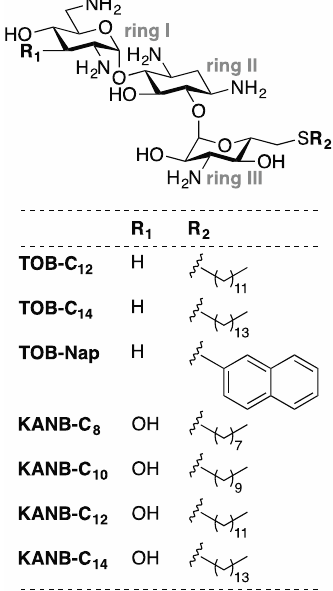
Figure 1. Compounds analyzed in this study. Related aminoglycosides TOB and KANB were modified with various 6” ‐ thioether substituents to generate the compounds shown. Derivatives of TOB (TOB ‐ C 12 , TOB ‐ C 14 , TOB ‐ Nap) and KANB (KANB ‐ C 8 , KANB ‐ C 10 , KANB ‐ C 12 , KANB ‐ C 14 ) differ chemically at two positions (R 1 and R 2 ) as indicated. Antibiotics 2020 , 9 , x FOR PEER REVIEW